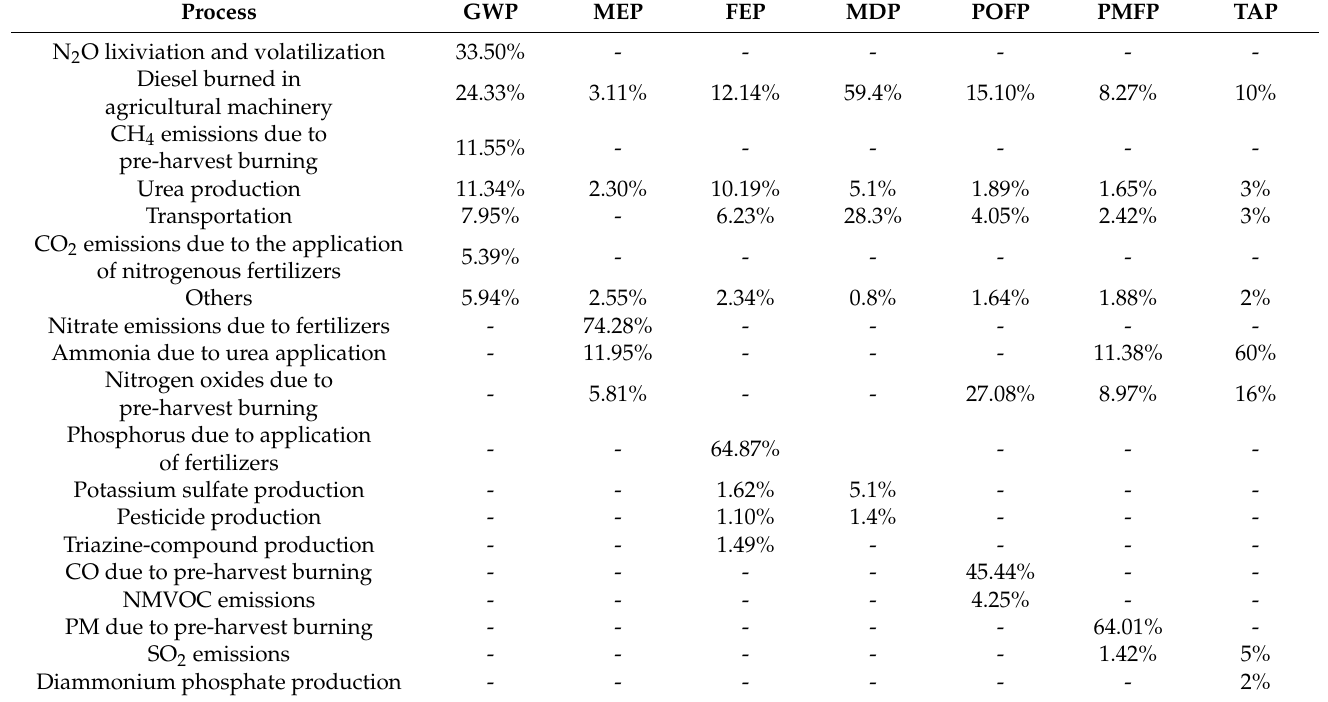
Table 4. Contribution analysis of agricultural stage for GWP, MEUP, FEP, MDP, POFP, PMFP, and TAP